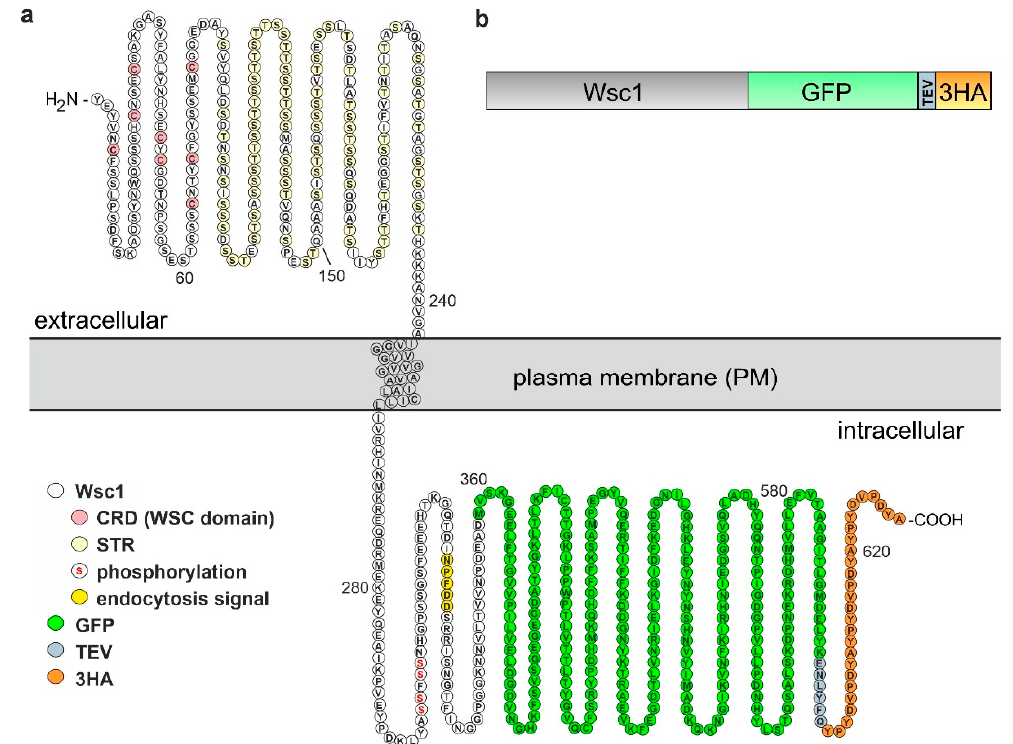
Figure 1. Schematic representations of the Wsc1 fusion construct employed in this work. ( a ) Primary structure of the sensor fusion protein indicating its orientation within the yeast plasma membrane, designed with Protter according to [47] and modified manually. Colour codes within the Wsc1 sequence highlight the eight cysteine residues characteristic of the WSC- or cysteine-rich domain (CRD), the residues believed to be glycosylated in the serine/threonine-rich region (STR; [6]), the serine residues within the cytoplasmic tail which could be phosphorylated [48], and the signal motif for endocytosis [46]. ( b ) Simplified overview of different protein sequences fused to the C-terminal end of Wsc1.